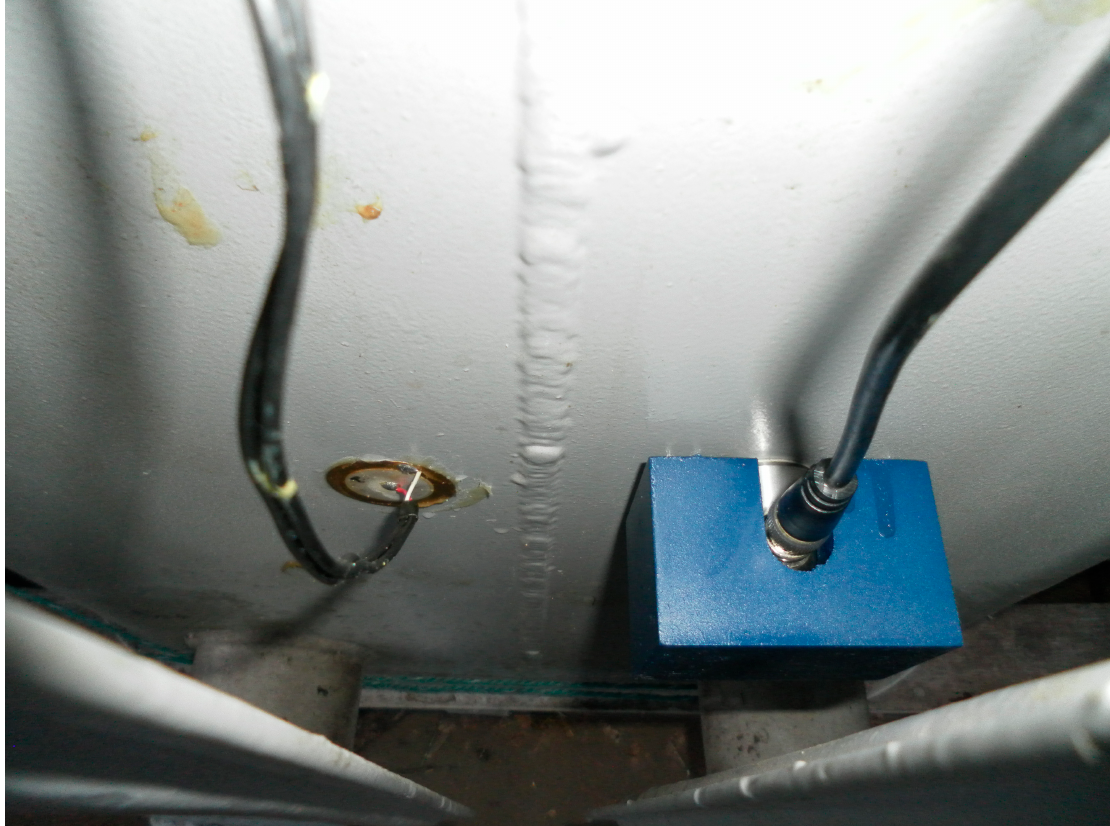
Figure 2. Experimental setup.